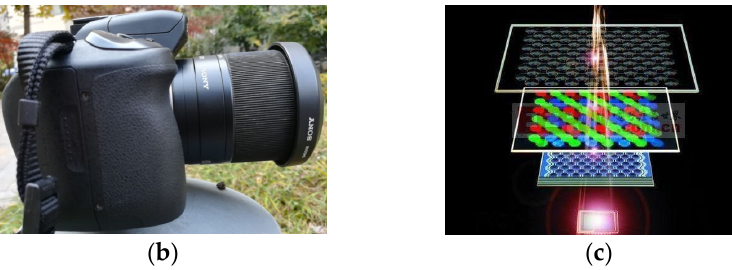
Figure 1. A Sony-350 camera was used for the monocular digital photography, displaying ( a ) front view, ( b ) side view, and ( c ) principle of CCD imaging.